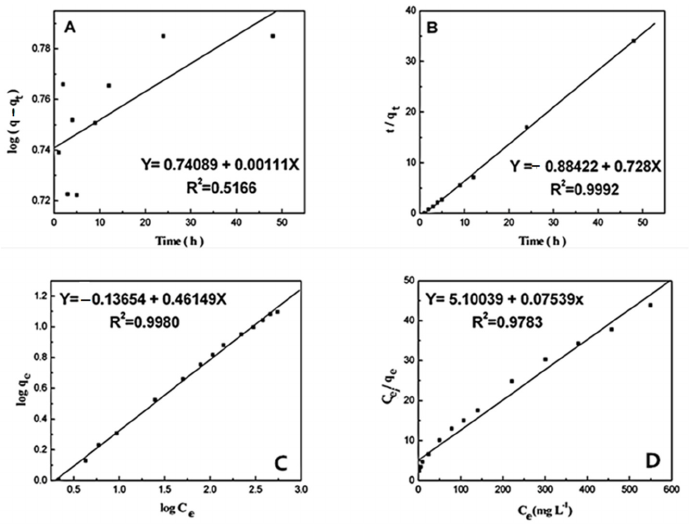
Figure 6. ( A ) The pseudo-first-order kinetics presented as a function of log( q e − q t ) versus time ( t ); ( B ) the pseudo-second-order kinetics presented as a function of t/q t versus time ( t ); ( C ) Freundlich isothermal adsorption of HSA on AgNPs surface; ( D ) Langmuir isothermal adsorption of HSA on the AgNPs surface. The linear form in pseudo-second-order kinetic equation is presented as below: